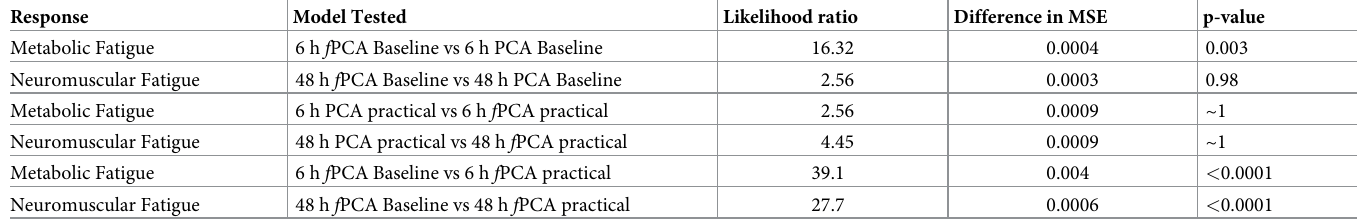
Table 3. Likelihood Ratio Test results for comparison of the linear mixed effects models used in rel PeakF prediction. The ratio describes the increase in goodness of fit (as measured by the log likelihood) for the first model compared to the second model, e.g. the difference in the log likelihood between the 6 h PCA baseline and the 6 h f PCA baseline models is 16.32. Here the better model is the one shown to have a statistically significant difference in